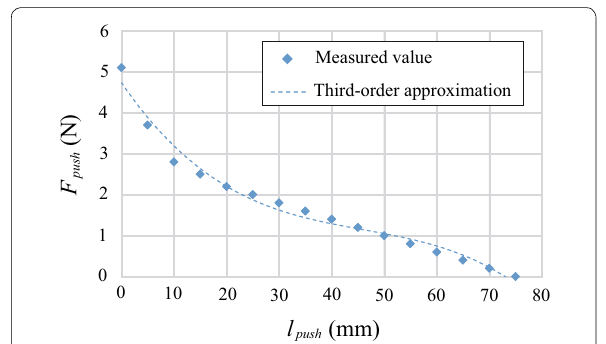
Fig. 36 Relation between distance l push (mm) and maximum pressing force F push (N) of the developed suction pad unit